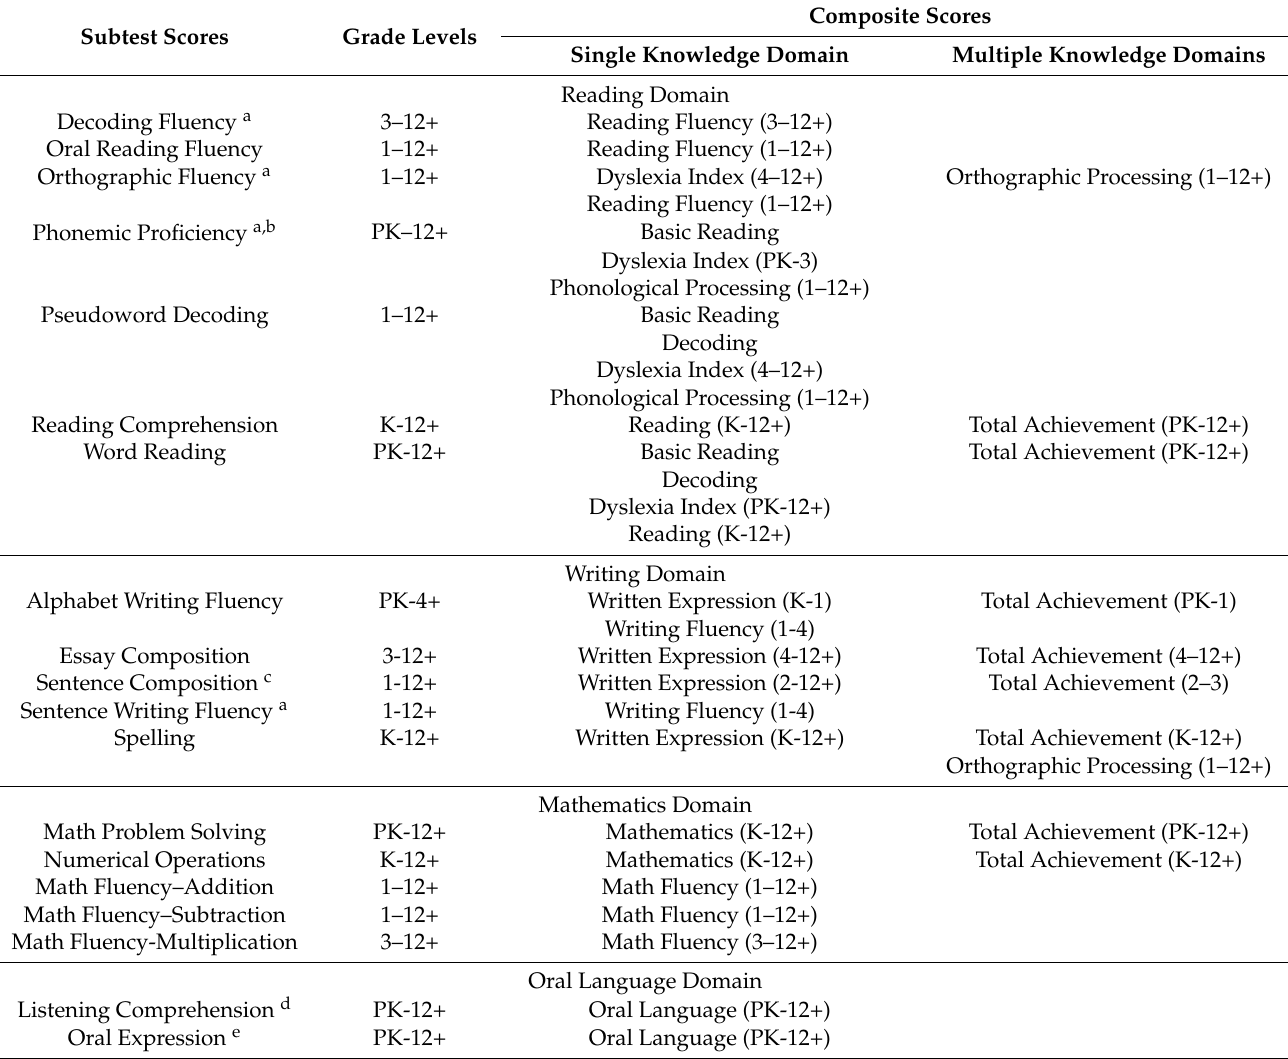
Table 1. Wechsler Individual Achievement Test—Fourth Edition